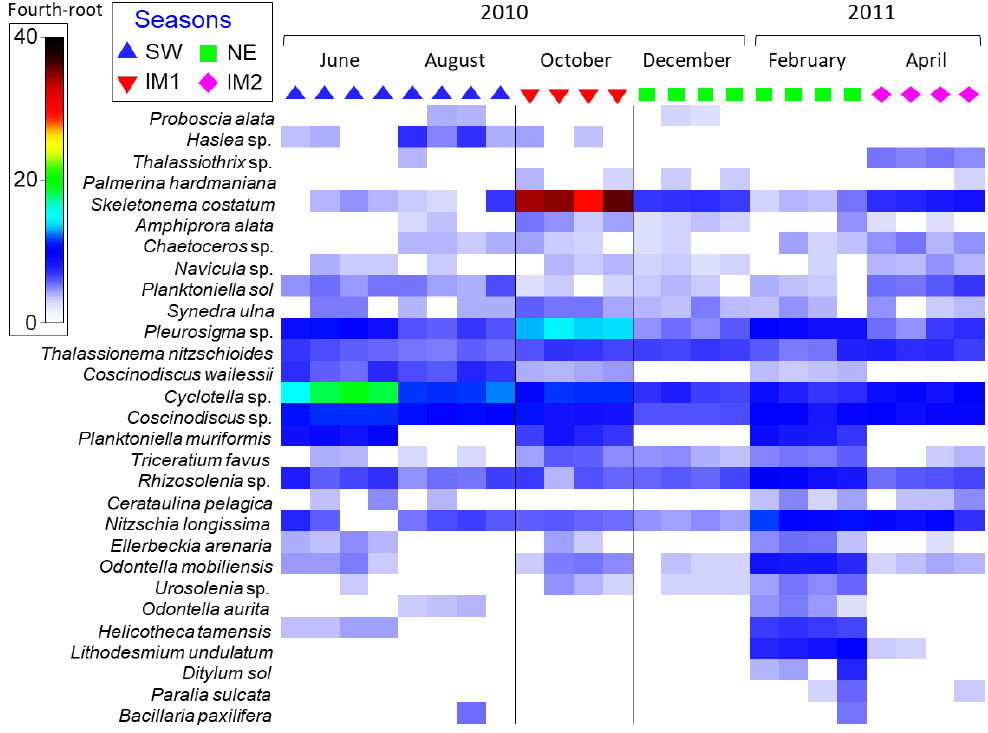
Figure 7. Shade plot, a visual representation abundances of a total of 50 diatom species out of 85 phytoplankton taxa across different stations and different monsoonal seasons with spectrum scale intensity proportional to the fourth-root abundance. The dendrogram shows species clustering using standard agglomerative methods of calculating group average, with white denotes the absence of the